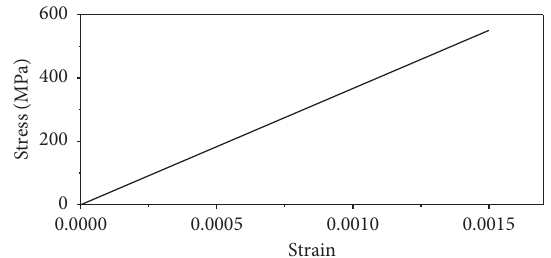
Figure 5: Sleeve stress-strain curve. Figure 6: Rebar stress-strain